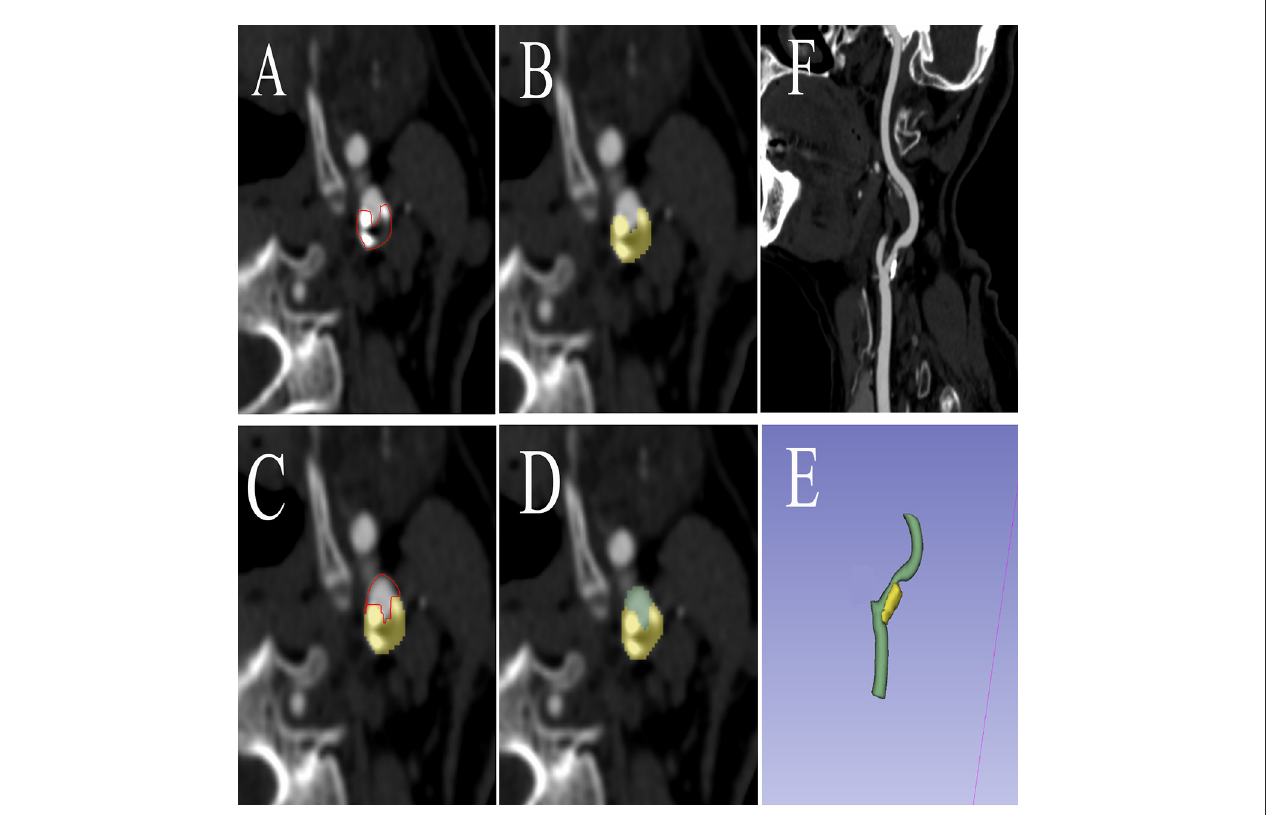
FIGURE2 The procedure of radiomics segmentation. The VOI in each image was segmented with the green arterial lumen and yellow plaques, and a 3D model was synthesized. (A) The edges of atherosclerotic plaques were delineated. (B) Atherosclerotic plaques were segmented. (C) The edges of arteries were delineated. (D) Arteries were segmented. (E) A 3D model was built based on the segmentation of each layer image. (F) Carotid artery CTA corresponding image of the patient. VOI, volume of interest; CTA, computed tomography